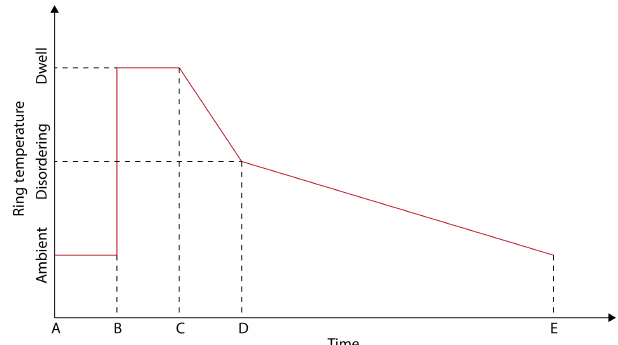
Figure 10. Example heat profile for a ring core showing a rapid heating from ambient temperature (A–B), a high-temperature dwell (B–C), a controlled ramp-down (C–D), and a slow ramp through the disordering range and down to ambient temperature